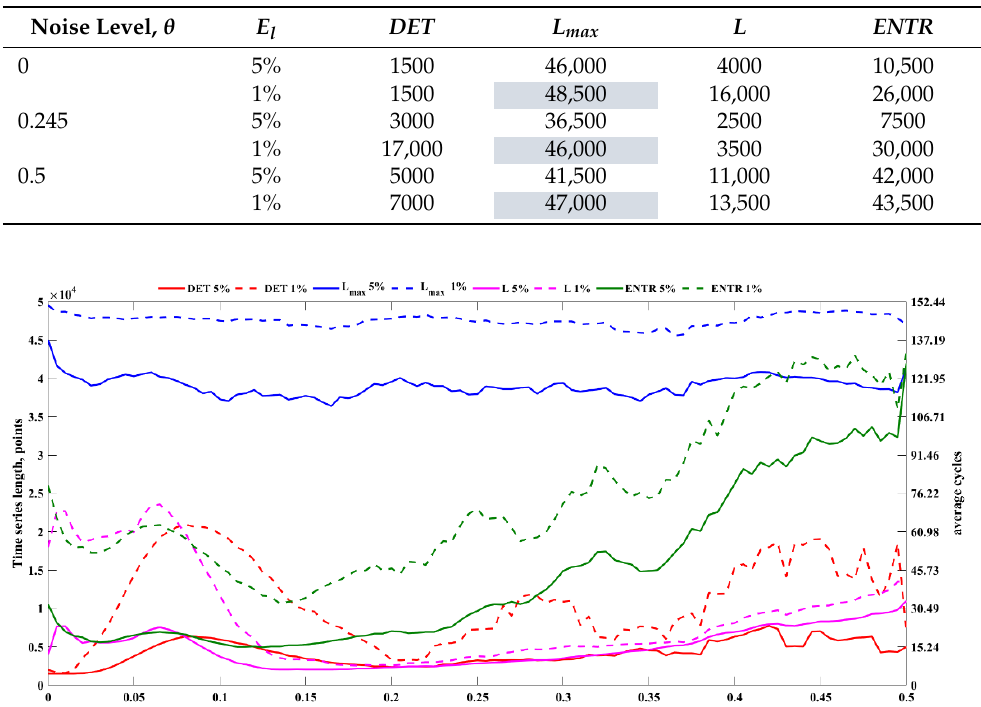
Table 2. Time series length corresponding to relative errors equal to 5% and 1% in the estimates of determinism, maximal diagonal line length, average diagonal line length, and entropy for three dif- ferent noise levels of the Rössler time series. The values highlighted indicate the lower limit of the length of the time series required for accurately estimating the four features.